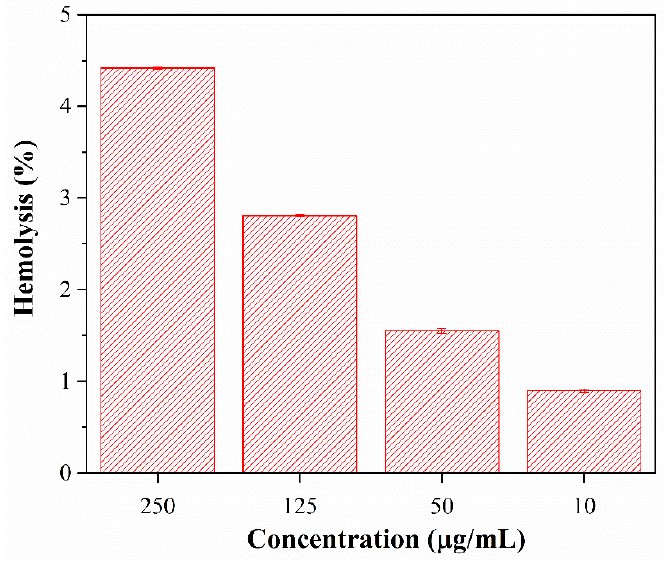
Figure 11. In vitro hemolysis (%) caused by different nanocomposite concentrations.